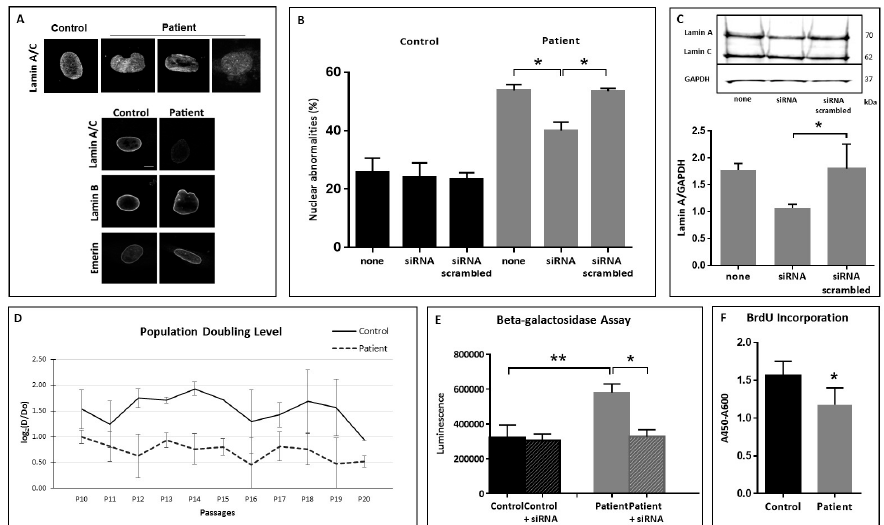
Figure 2. Nuclear shape anomalies and senescence tests. ( A ) Representative pictures of nuclear anomalies. Upper panel: aberrant nuclear pattern, aberrant cytoplasmic localization and aberrant shape after lamin A staining. Fibroblasts were examined with Apotome.2 (Zeiss) stereomicroscope under oil immersion (100× magnification). Lower panel: representative pictures of nuclear anomalies with different staining (Lamin A/C, Lamin B and Emerin); ( B ) Quantitative estimation of dysmorphic nuclei in control and patient fibroblasts with and without siRNA. Asterisks correspond to p values of 0.0268; ( C ) Representative Western Blot and quantitative estimation of lamin A in patient fibroblasts with and without siRNA. Asterisk corresponds to a p value of 0.0286; ( D ) Population Doubling Level. ANOVA showed p < 0.0001 between control and patient PDL; ( E ) Senescence related beta-galactosidase activity before and 24h after siRNA treatment. The double asterisk corresponds to a p value of 0.0079; the asterisk corresponds to a p value of 0.0159. ( F ) BrdU incorporation. Asterisk corresponds to a p value of 0.0173. In all experiments, “control” was fibroblasts from healthy people.